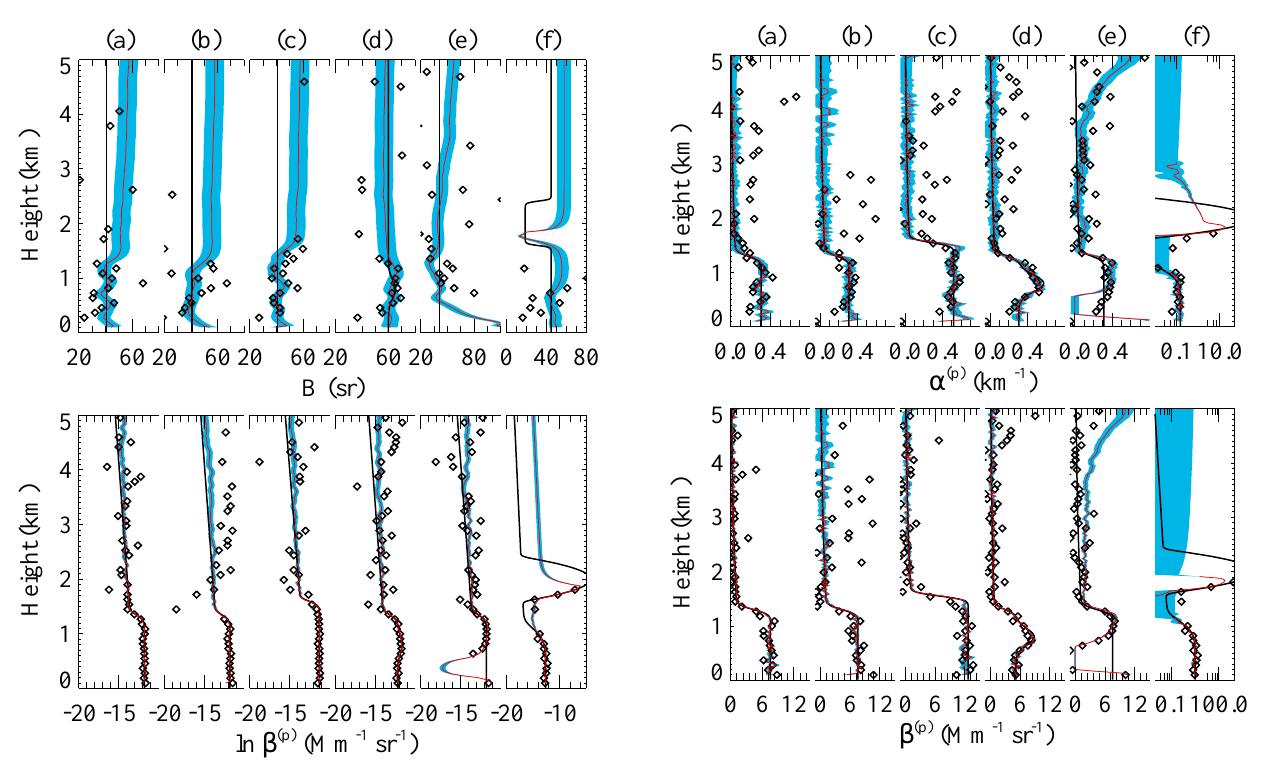
Fig. 10. As Fig. 9 but for the extinction configuration. Fig. 9. Retrieval from the lidar ratio configuration (red) showing its error (blue) compared to that of the Ansmann method at 300 m resolution (diamonds) and the simulated profile (black). 44